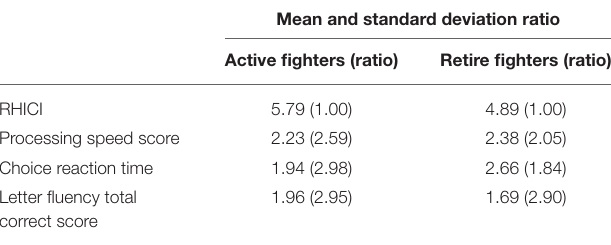
TABLE 2 | Comparison of the mean and standard deviation ratio between the Repetitive Head Impact Composite Index (RHICI) and individual scores on processing speed, choice reaction time, or letter fluency